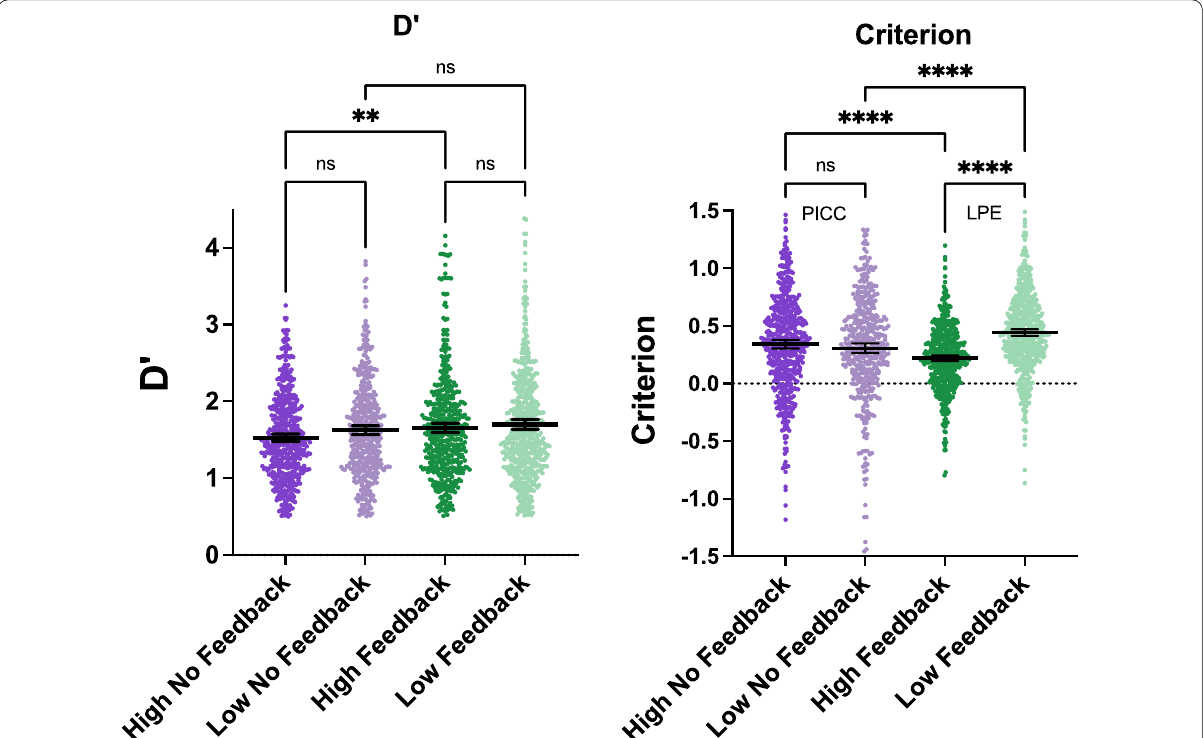
Fig. 2 D ′ and criterion as a function of condition. Each dot represents one of 2080 blocks of data. Black lines show mean and